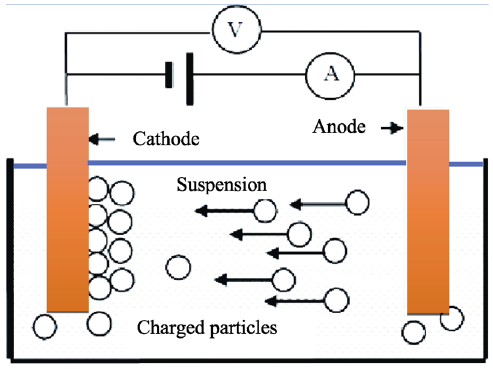
Fig. 19 Schematic diagram of electro-phoretic deposition and electroforming principal.